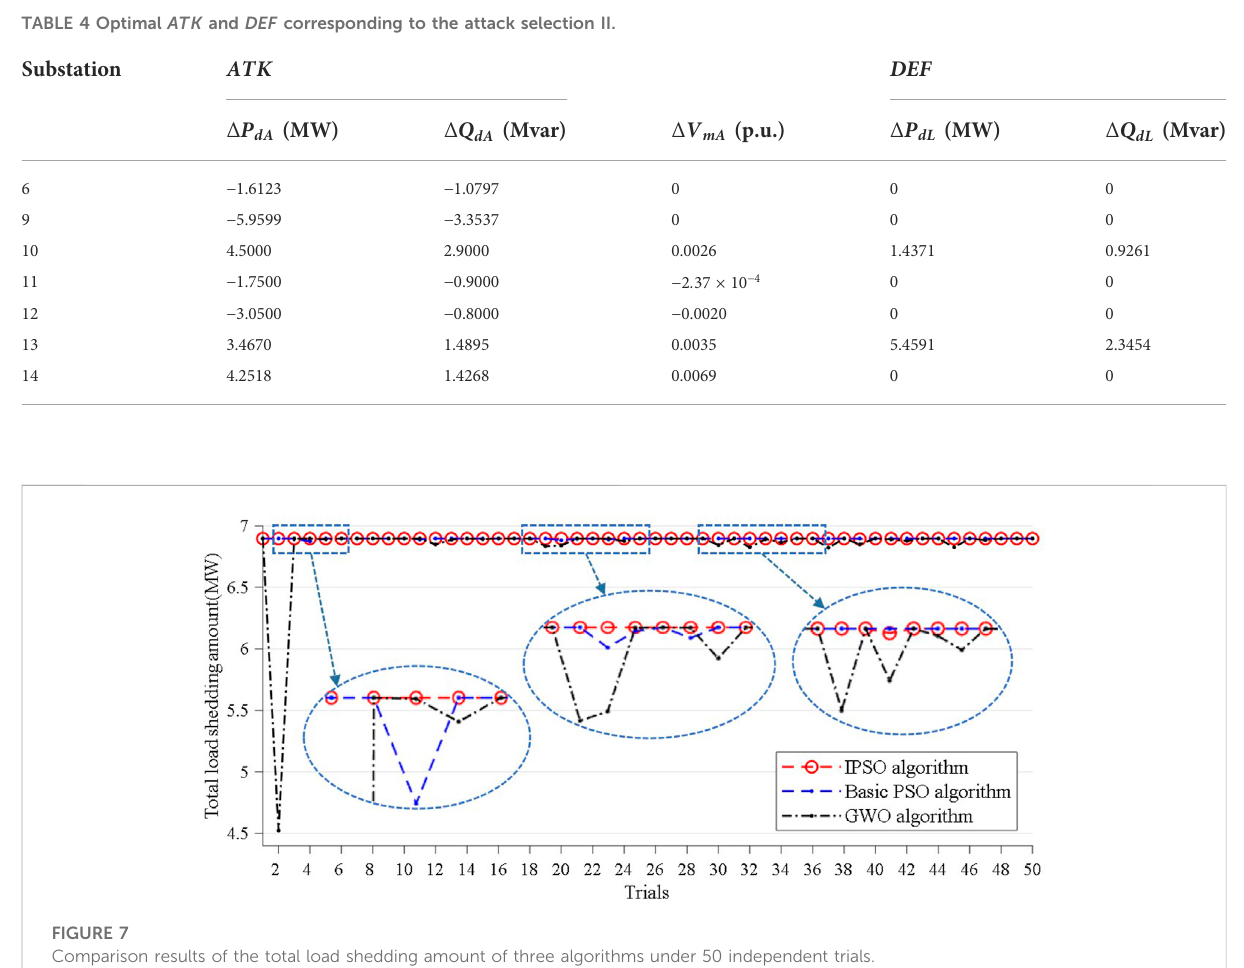
TABLE 4 Optimal ATK and DEF corresponding to the attack selection II.